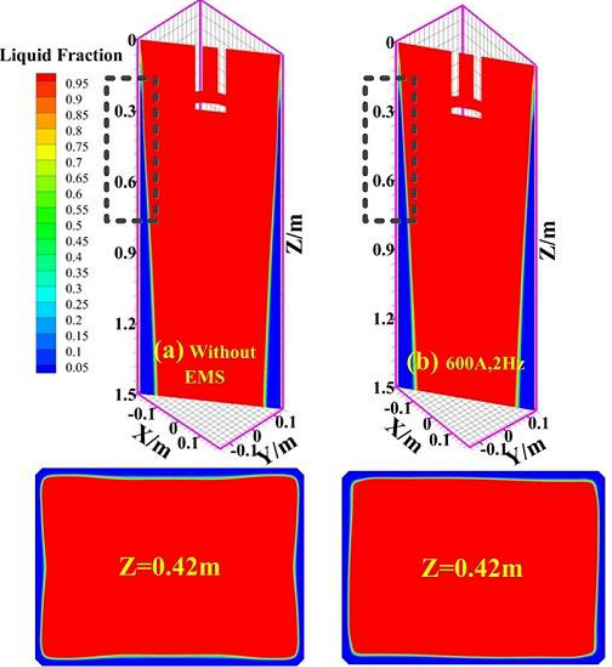
Figure 11. Liquid fraction distributions at the diagonal plane and the EMS center for different cases. Metals 2017 , 7 , 72